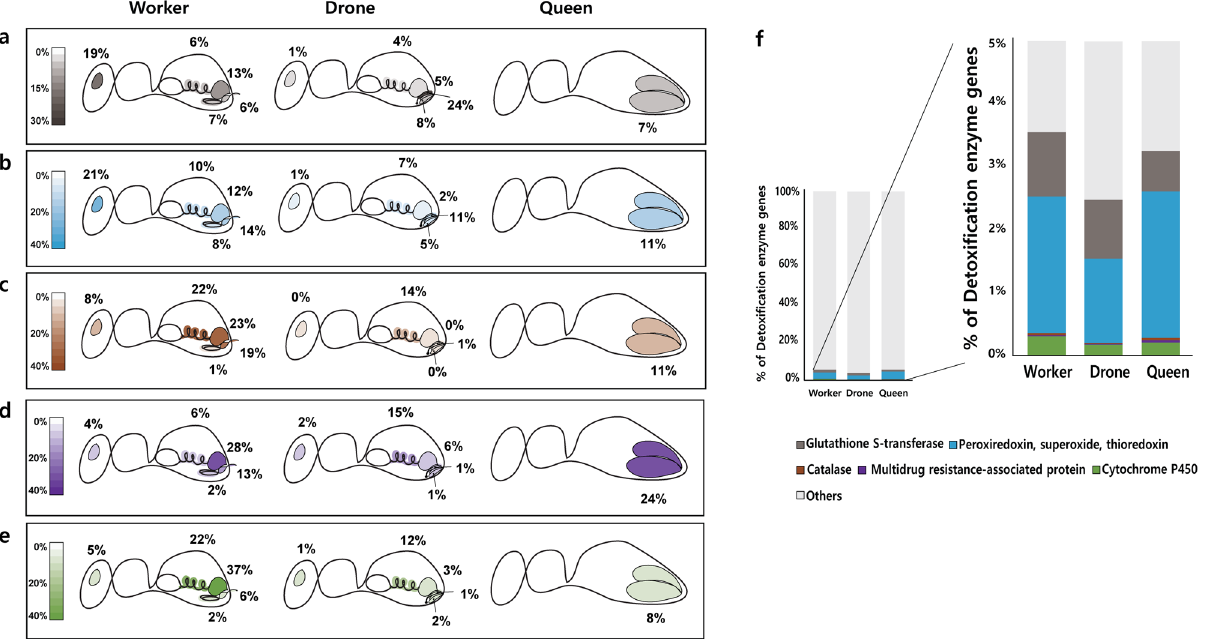
Figure 5. Expression differences in detoxification machineries among castes. Caste and organ distribution of detoxification machineries genes ( a ) Glutathione-S-transferases (GST) transcripts (shown in gray). ( b ) Peroxiredoxin, superoxide, superoxide and thioredoxin transcripts (shown in blue). ( c ) Catalase (shown in brown). ( d ) Multidrug resistance-associated protein (shown in purple). ( e ) Cytochrome P450 (shown in green). Expression ratio showed the proportion of detoxification-related transcripts expressed among organs in each caste (a-e). The collected organs are shown. Modified illustration of the honeybees was adapted with permission from Professor Leonard J. Foster, the corresponding author of Genome Research (2013), 23, 1951–1960. ( f ) The percent of all quantified detoxification machineries in each